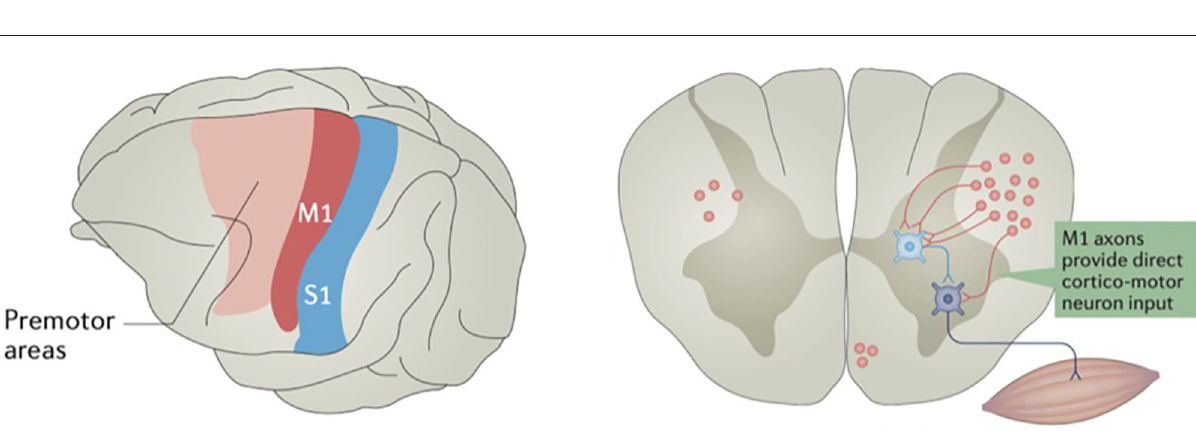
shown both interindividual variability and plasticity in recovery from deficits (52), suggesting a neural network model that can modulate function in a dynamic fashion (19). This has been